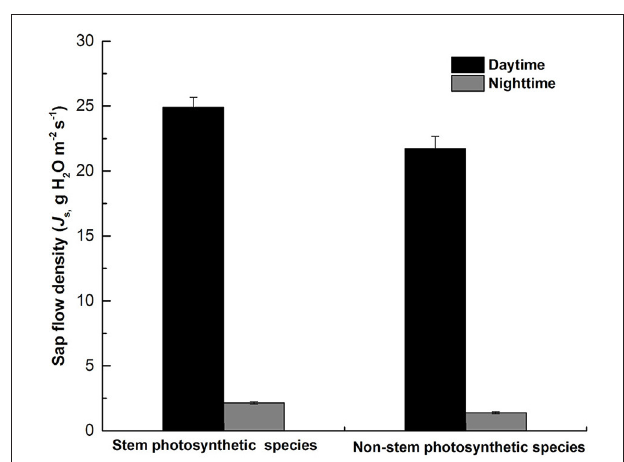
FIGURE 5 | The difference of daytime mean sap flux ( J s,d ) and nighttime mean sap flux ( J s,n ) between the two groups of species (stem photosynthetic species and non-stem photosynthetic species). Data are means ±